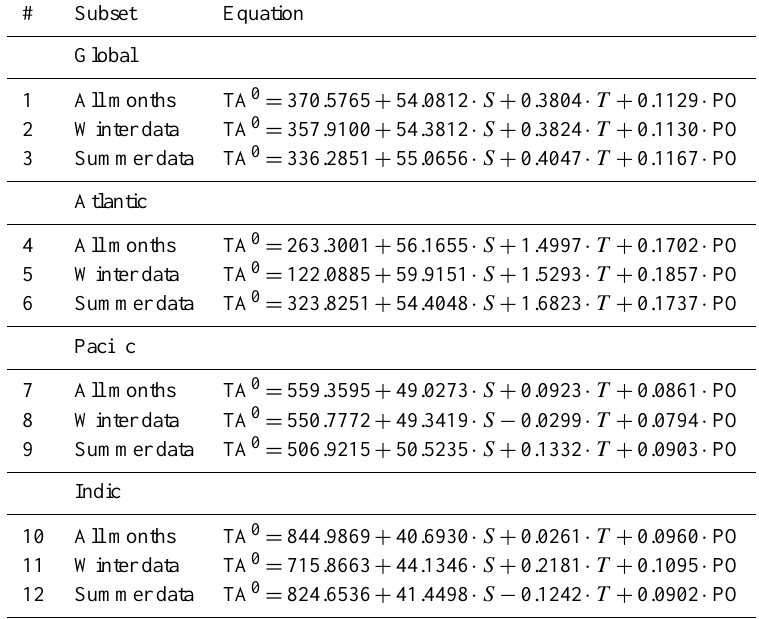
Table 1. TA 0 algorithms. Algorithms are derived from surface data (upper 100m) of the model. Subsets “winter data” “summer data”) use surface data from winter (summer) months of the respective hemispheres only. Basin-specific algorithms are based on data from the respective ocean basin.